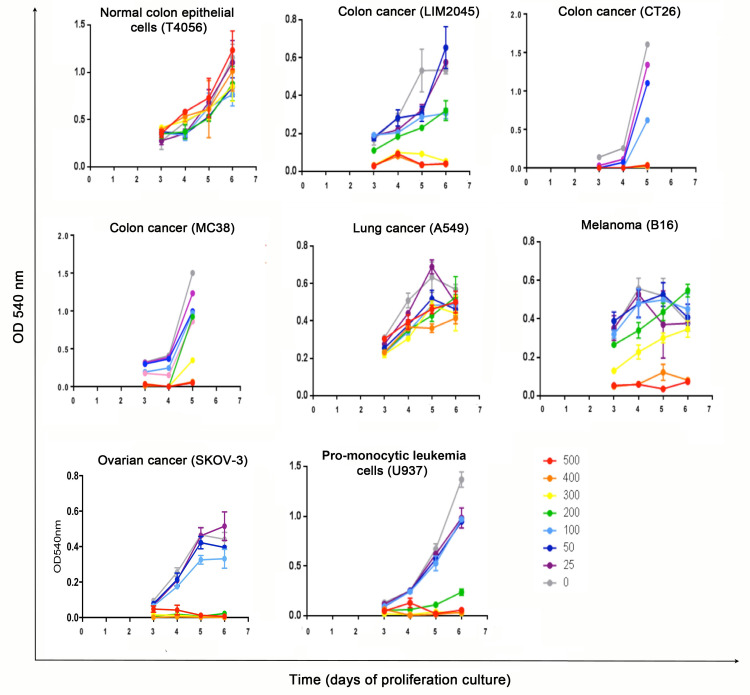
MTT cell assays showing proliferation between days 3–6 of cancer cell lines LIM2045, CT26, MC38, A549, B16, SKOV-3 and U937 in the presence of PRSE 0–500 μg/ml; T4056 is a normal colon epithelial cell line.Absorbance was measured at each time point at 540 nm.